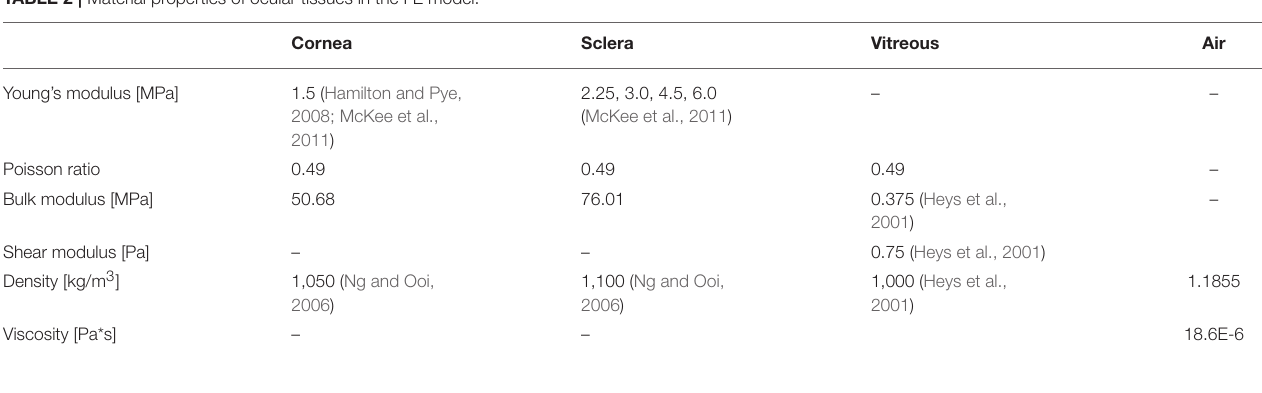
FIGURE 3 | (Left) The undeformed geometry of the eye, where the interior boundary of the ocular tunic is highlighted in blue to indicate where the negative IOP will be applied to estimate the stress-free geometry of the eye. (Center) The resultant stress-free state of the eye (in blue) compared to the original undeformed geometry prior to loading by the negative IOP (in black). (Right) Von Mises stresses in the residually-stressed state of the eye when loaded by IOP, where the black lines represent the geometry of the stress-free state of the eye prior to loading by IOP. TABLE 2 | Material properties of ocular tissues in the FE